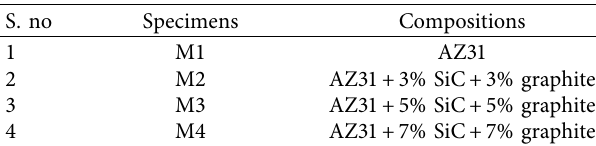
Figure 1: Photograph of the bottom pouring-type stir casting machine. Table 1: Designation of